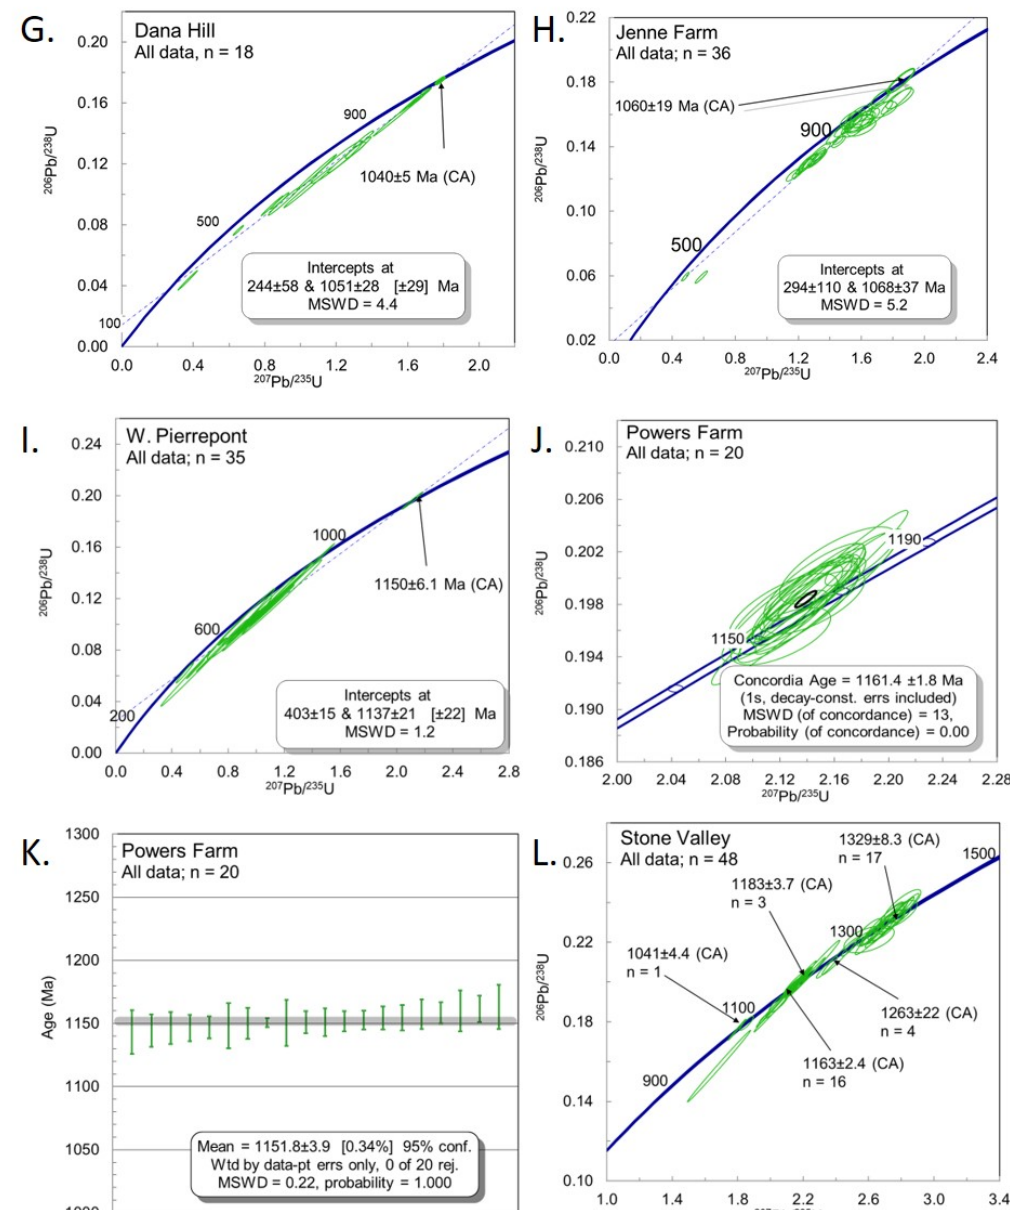
Figure 5. Concordia diagrams for the samples analyzed in this study. See text for explanation. Locations include: ( A ) Hickory Lake; ( B ) Fine; ( C ) Keene Valley; ( D ) Natural Bridge; ( E ) Rose Road; ( F ) Edwards; ( G ) Dana Hill; ( H ) Jenne Farm; ( I ) W. Pierrepont; ( J ) Powers Farm; ( K ) Powers Farm (Weighted Mean); ( L ) Stone Valley.